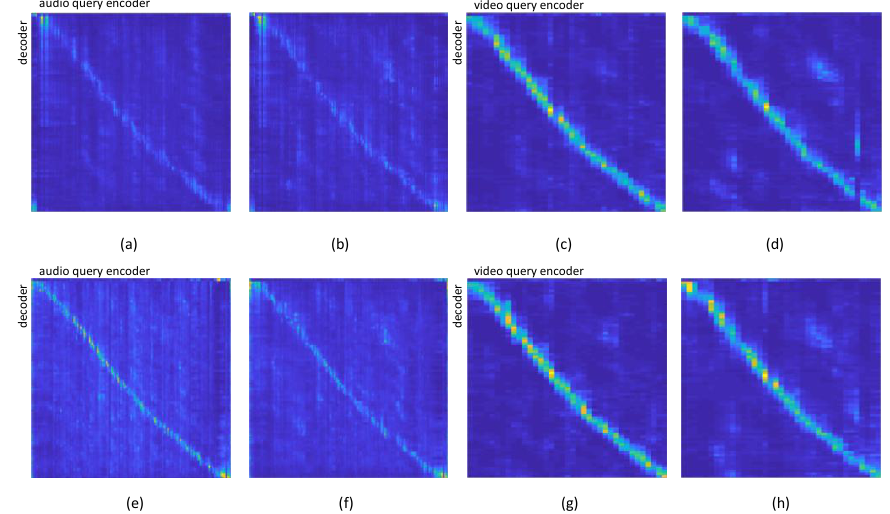
Figure 7. Encoder–decoder attention weight maps using the DCM attention outputs as keys and values in the TM-DCM for the cross-entropy and hybrid CTC/attention losses. The weight maps were displayed for both clean and noisy reverberant data, and the used clean and noisy reverberant data were the same as in Figure 6. The weights were computed by averaging over all the encoder–decoder attention heads at all decoder layers. The weight maps for ( a – d ) the cross-entropy loss and ( e – h ) the hybrid CTC/attention loss; the weight maps between ( a , e ) audio encoders and decoders using clean audio input; ( b , f ) audio encoders and decoders using noisy reverberant audio input; ( c , g ) video encoders and decoders using clean audio input; and ( d , h ) video encoders and decoders using noisy reverberant audio